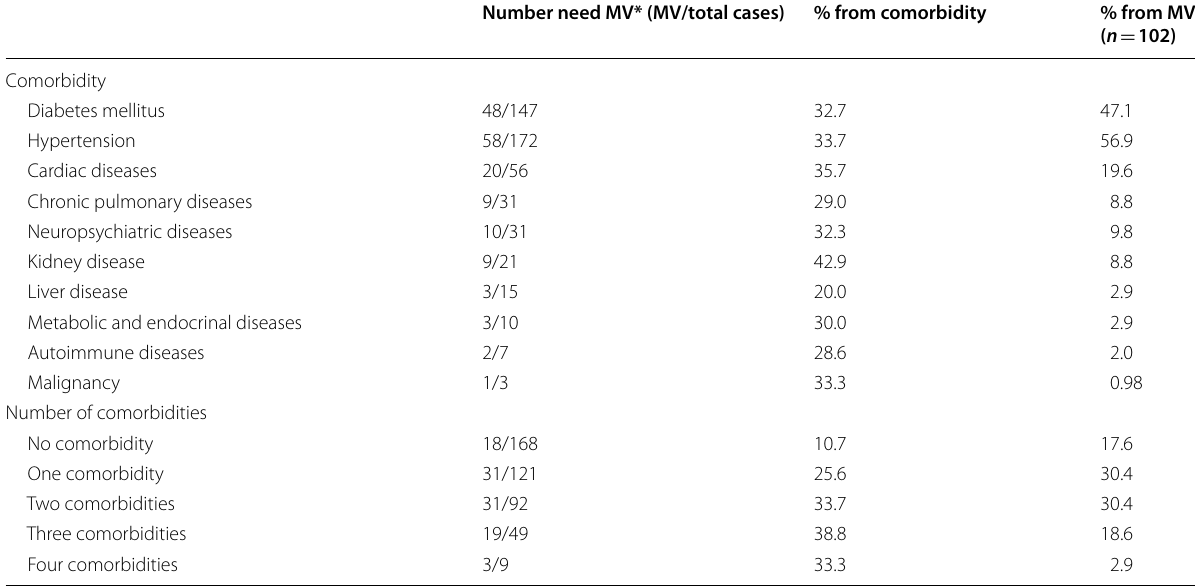
Table 5 Percentage needed mechanical ventilation from each comorbidity Number need MV* (MV/total